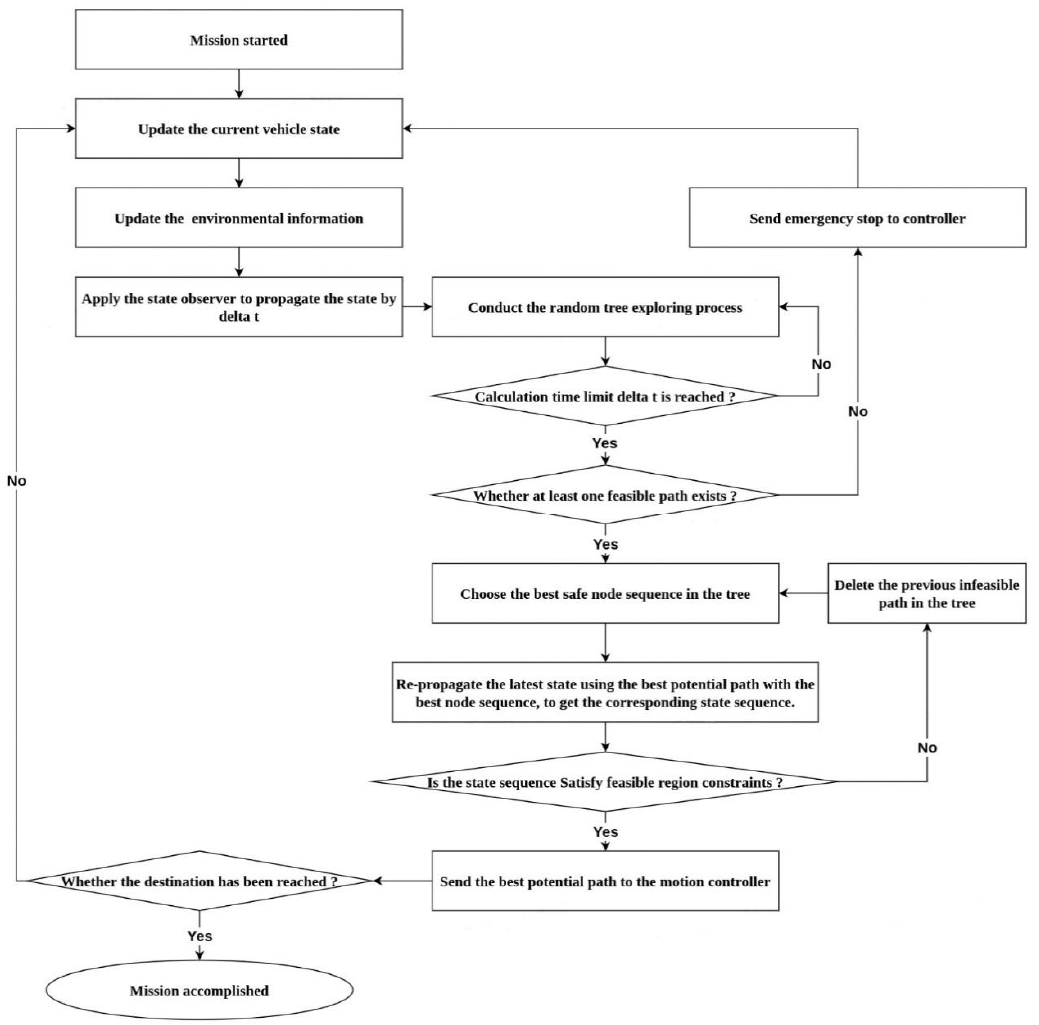
Figure 3. The pipeline of the TS-RRT planner.